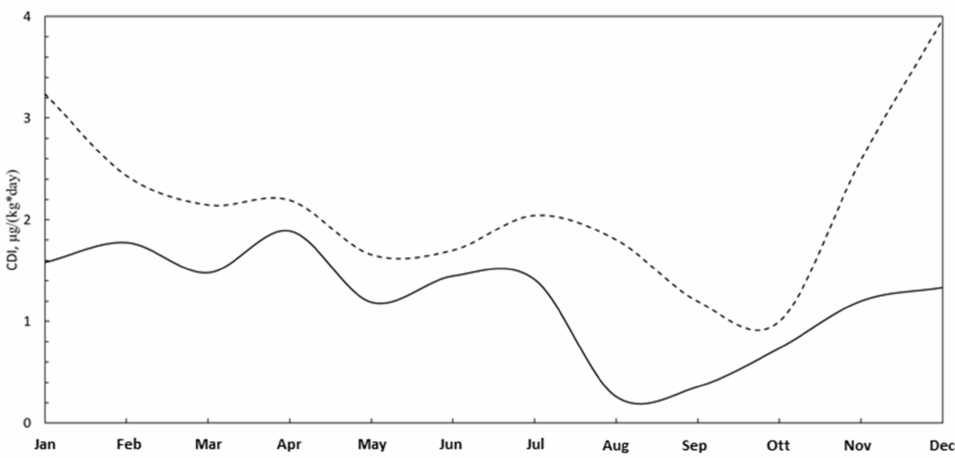
Figure 10. Arsenic (As) CDI for the HI (solid black line) and LI (dashed black line) area for every month in